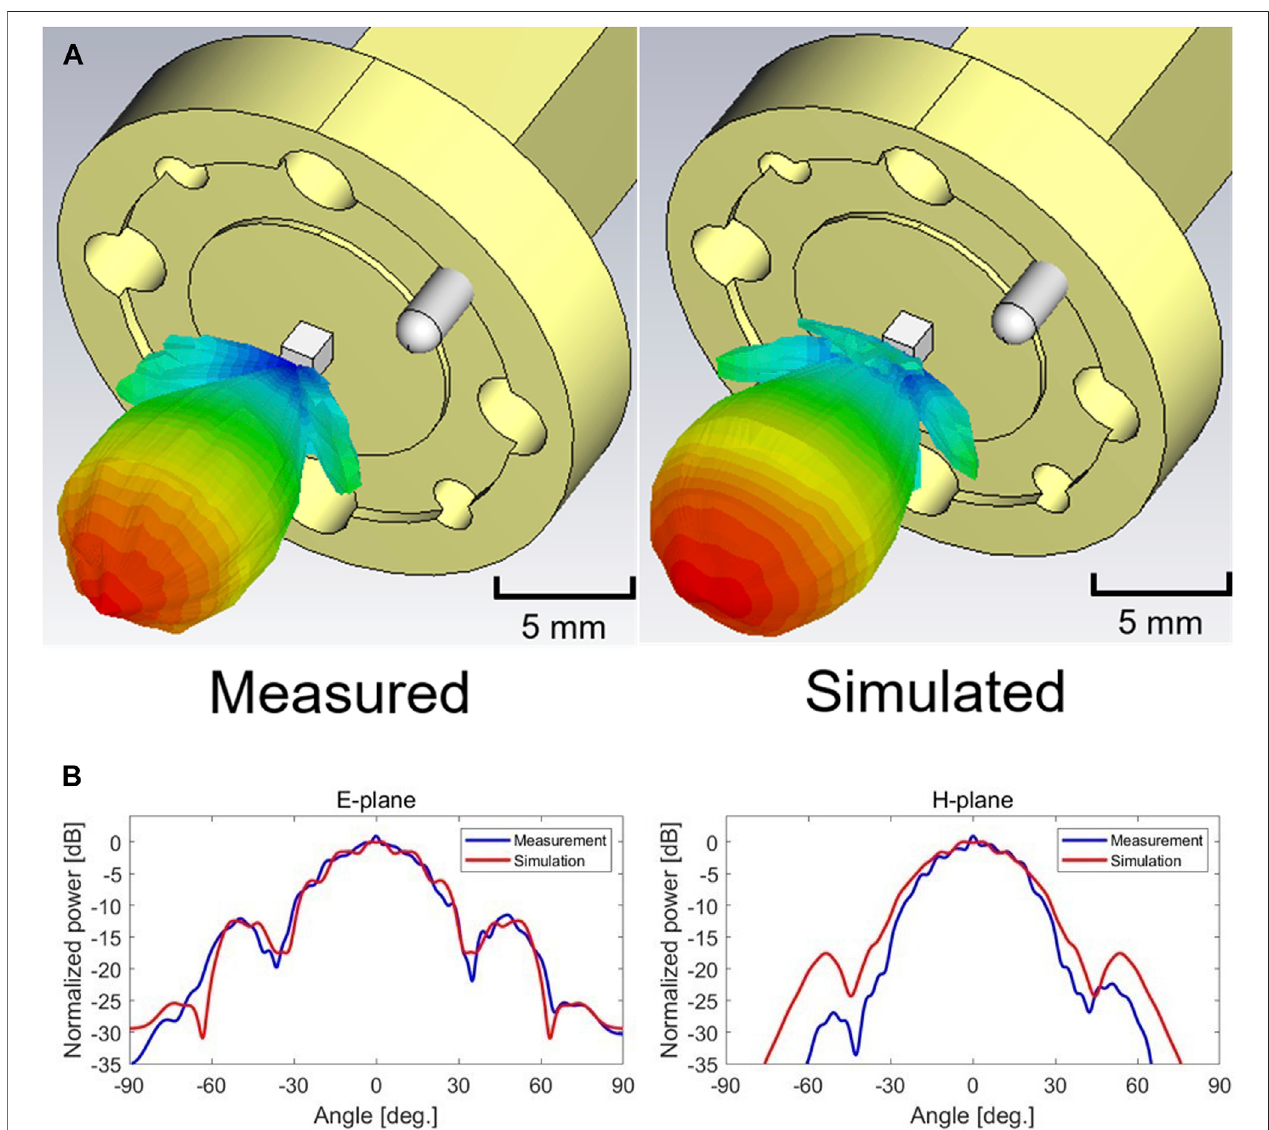
FIGURE4| DCAradiationpattern (A) 2Dradiationpatterncalculatedfromthemeasuredandsimulatednear- fi elddistribution (B) One-dimensionalradiationpattern in the E- and H-planes extracted from the 2D data.